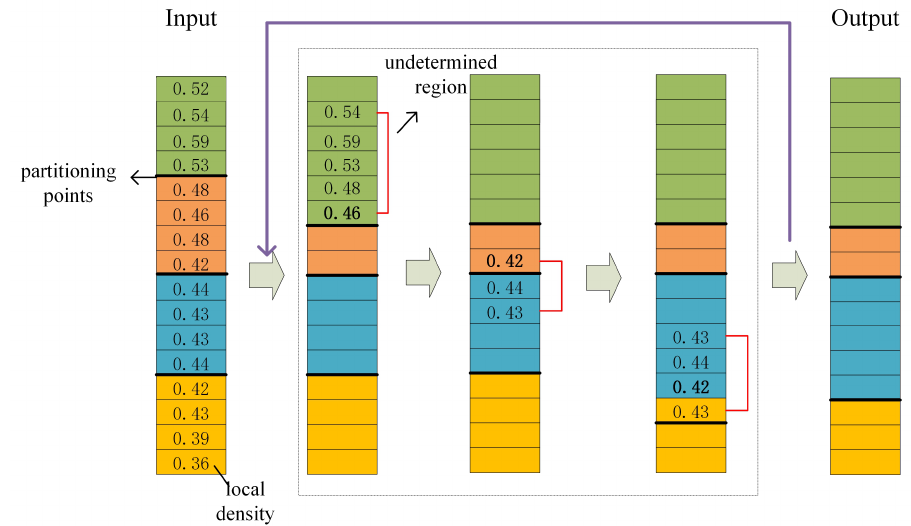
Figure 3. An example of fine grouping to partition 16 bands. Assume that the input and output are, respectively, the result of coarse grouping and fine